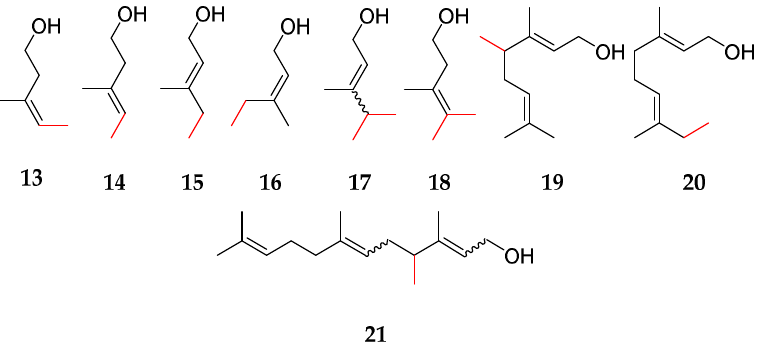
Figure 3. Structures of methylated terpenes described by Drummond et al. with red-labeled bonds to the additional methyl groups: ( Z )-4-methylisoprenol 13 , ( E )-4-methylisoprenol 14 , ( E )-4-methylprenol 15 , ( Z )-4-methylprenol 16 , 4,4-dimethylprenol 17 , 4,4-dimethylisoprenol 18 , 4-methylgeraniol 19 , 8-methylgeraniol 20 , and 4-methylfarnesol 21.